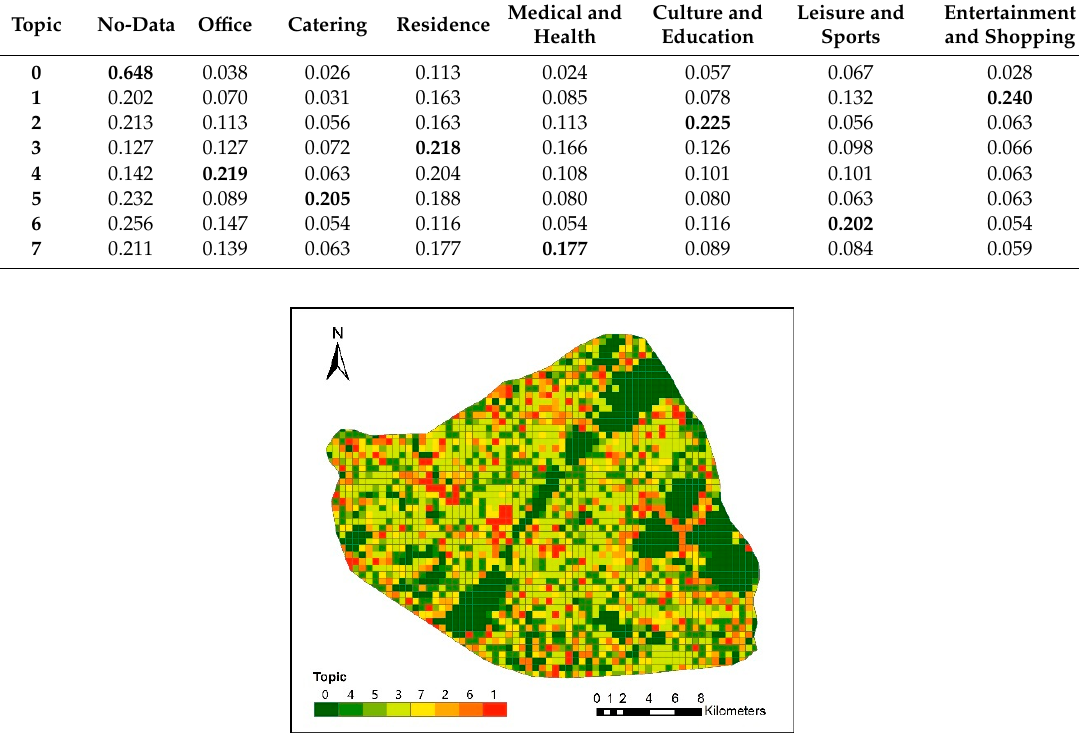
Table 3. Proportion of different functional categories in each topic.